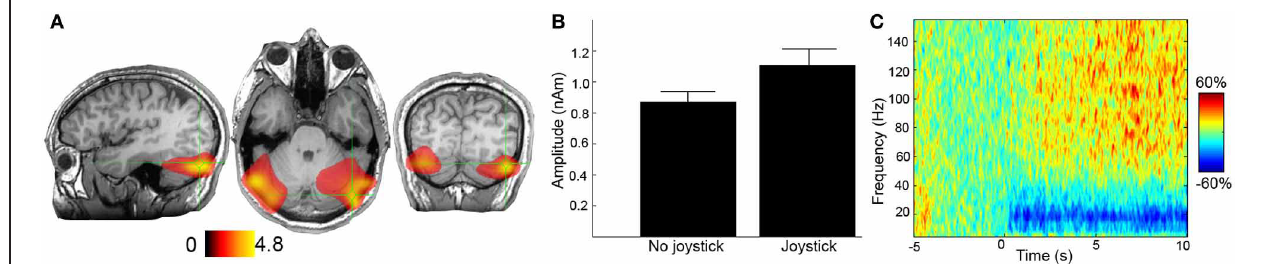
FIGURE 2 | Example of muscle artifacts in MEG data. In this task (Kennedy et al., 2011), participants are asked to either track a moving object on screen with a joystick or simply observe the moving object. (A) The difference in 50–100Hz source power is presented for the joystick and no-joystick conditions for a single participant. Units are pseudo t -values. (B) Peak-source amplitudes for the two conditions for the right hand source location. Based on panels (A) and (B) it would be tempting to speculate that tracking with the joystick has caused an increase in high-frequency activity in the bilateral cerebellar cortices; however, in panel (C) the reconstructed time-frequency spectrum is presented (10s of tracking, baselined to 5s of rest—units are percentage change from baseline). It is immediately apparent